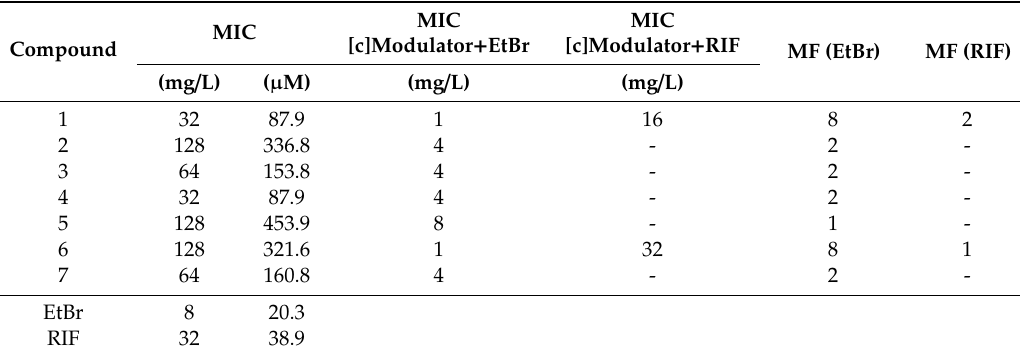
Table 1. Antimicrobial and resistance-modulating activity of the substrates against M. smegmatis mc 2 155 detected by microbroth dilution